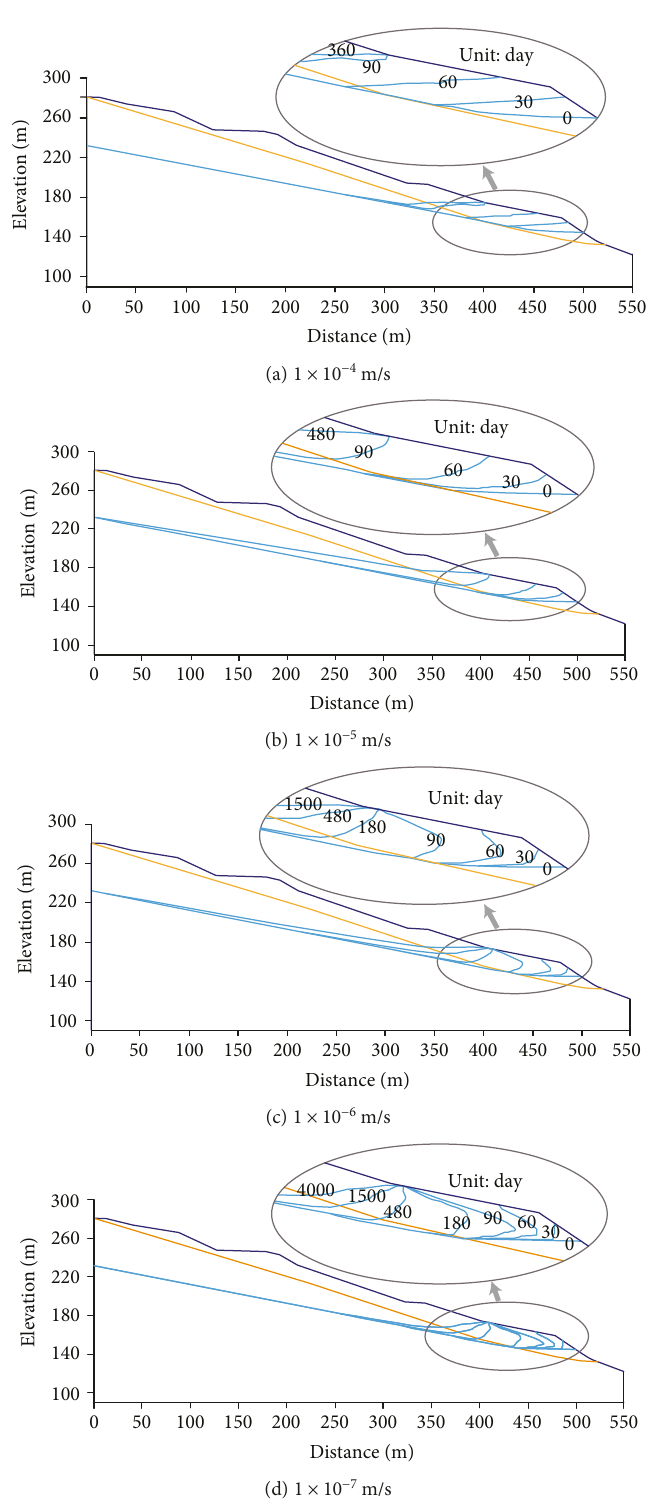
Figure 13: Saturation lines during rising (from 145 m to 175m in 90 days) and maintaining of the reservoir